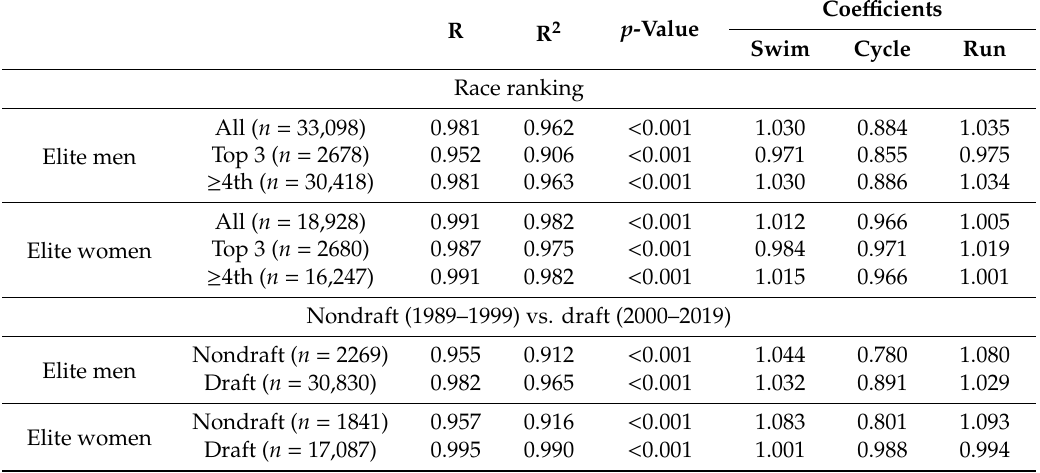
Table 1. Multivariate regression results to determine discipline influence in Olympic triathlon altogether and clustered by race ranking and between decades with and without draft rules.